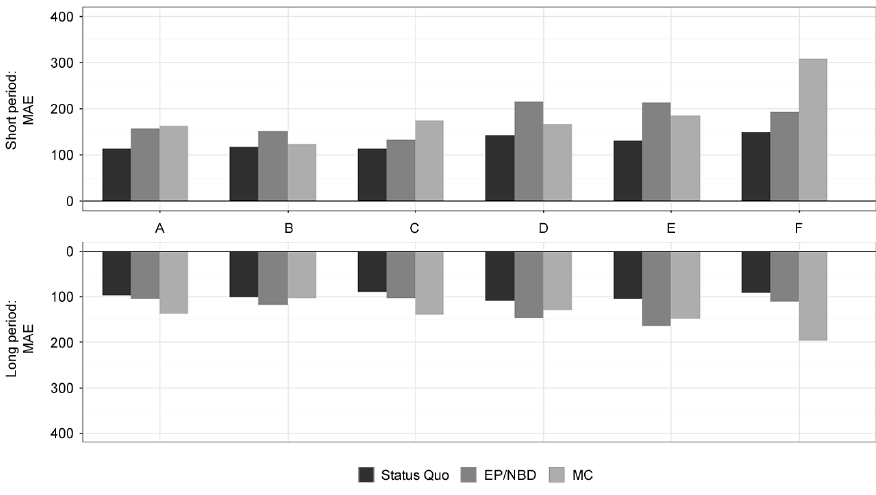
Figure A2. Results for MAPE (weekly-level, in %) for online stores A-F. Source: Authors . Informatics 2018 , 5 , 2